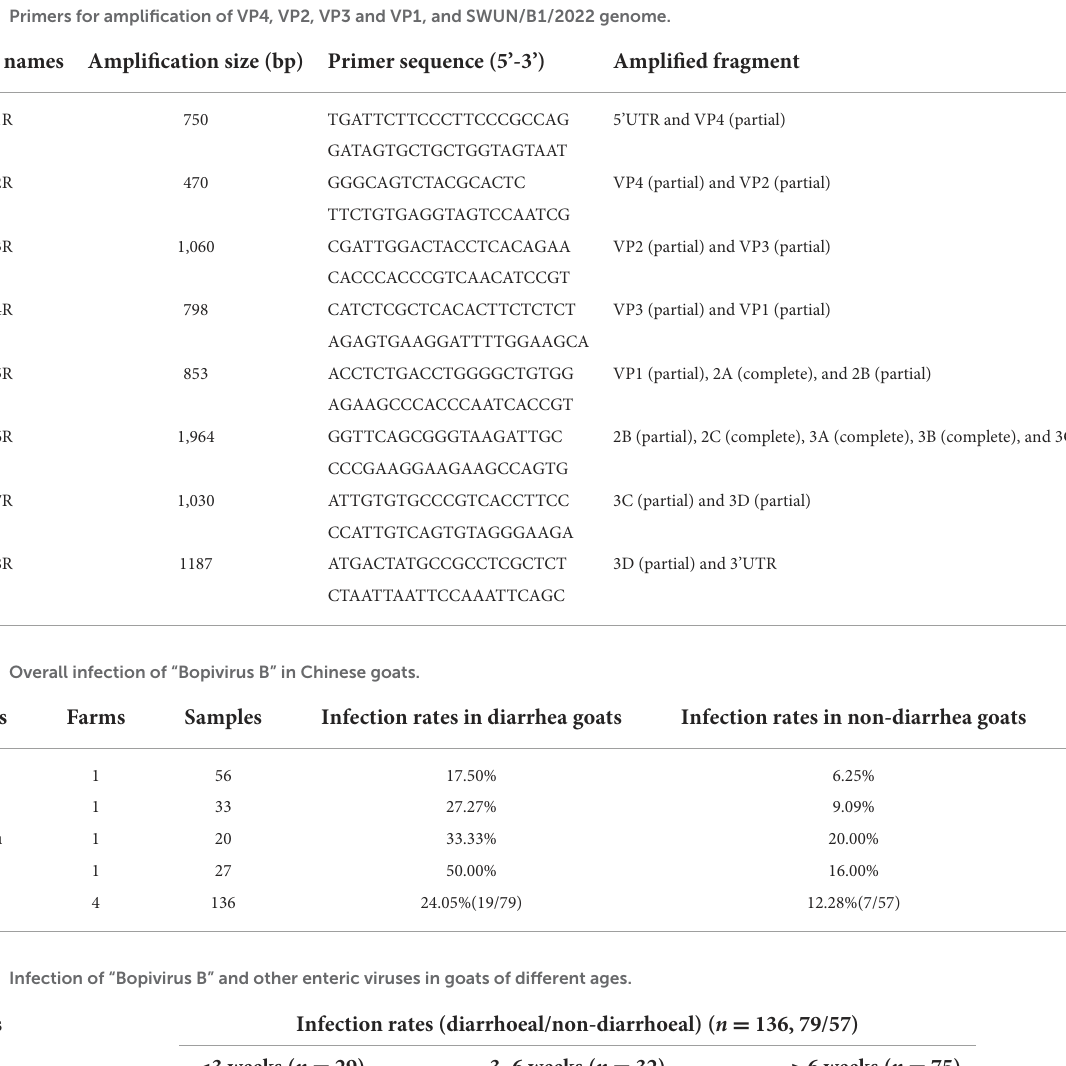
TABLE 1 Primers for amplification of VP4, VP2, VP3 and VP1, and SWUN/B1/2022 genome.